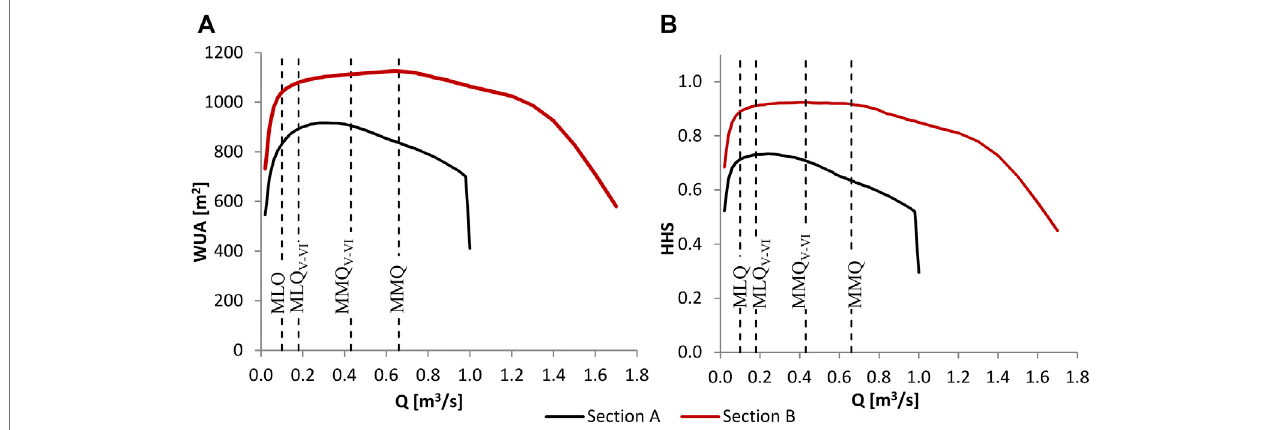
FIGURE 4 | WUA ~ Q (A) and HHS ~ Q curves (B) . MLQ, mean of the low periodic fl ows; MLQ V-VI , mean of the low periodic fl ows for the months of May-June; MMQ, mean of the mean periodic fl ows; MMQ V-VI , mean of the mean periodic fl ows for the months of